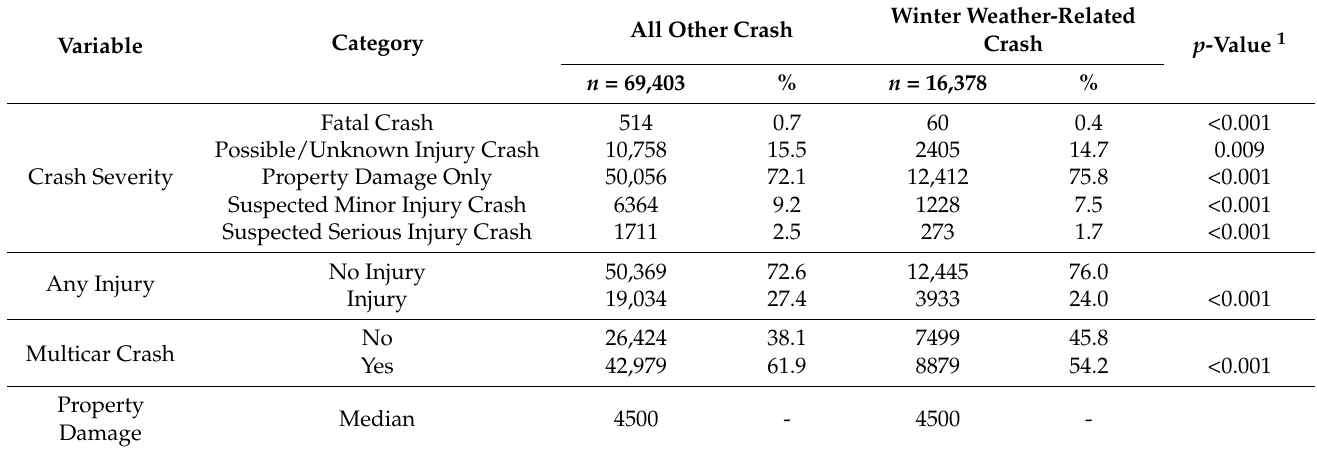
Table 3. Crash severity for crashes with and without a winter weather-related